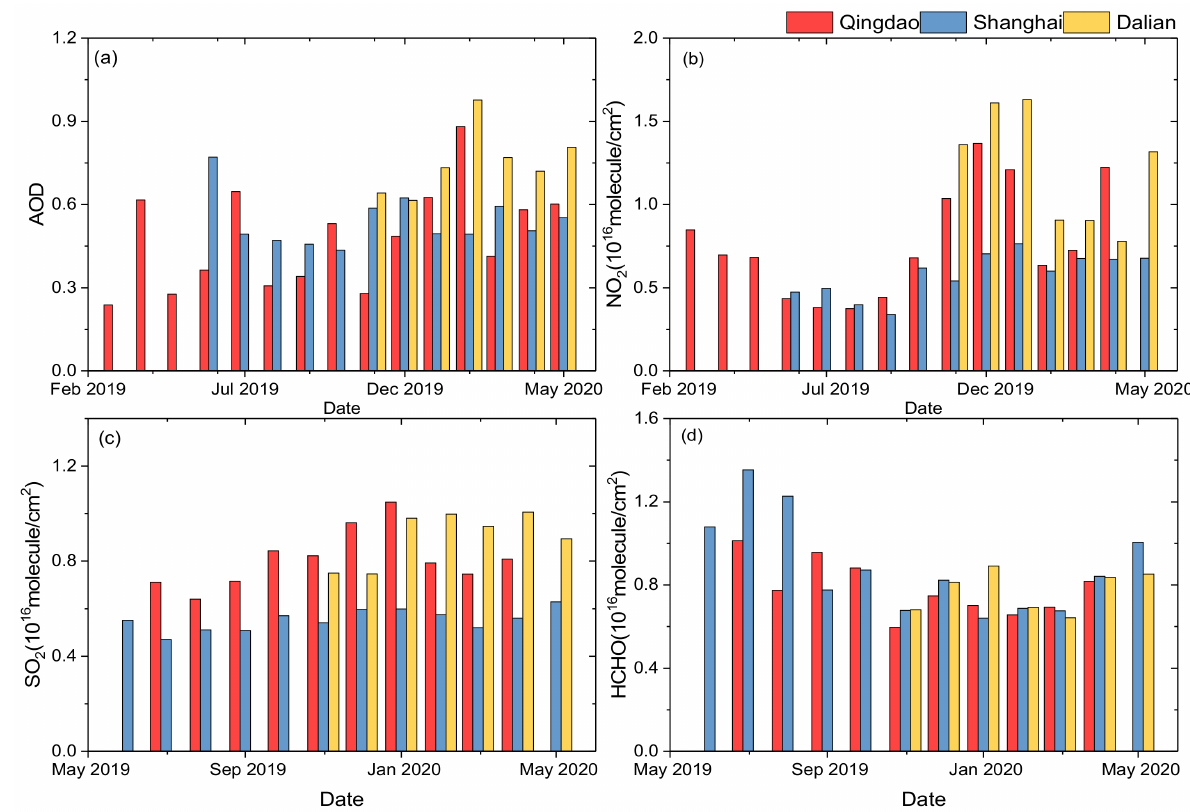
Figure 5. Monthly average aerosol optical depth (AOD) ( a ) and vertical column densities (VCDs) for NO 2 ( b ), SO 2 ( c ) and HCHO ( d ) in Qingdao, Shanghai, and